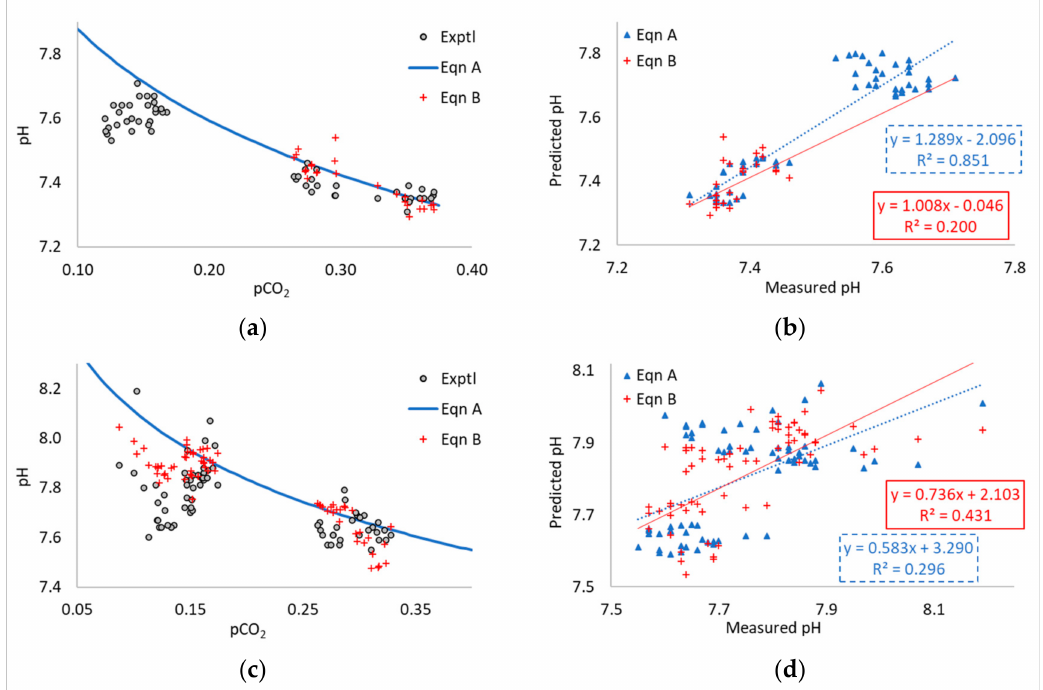
Figure A6. Experimental pCO 2 and pH values and predicted pH from Equation A for mesophilic ( a , b ) and thermophilic ( c , d ) CO 2 biomethanisation of pig manure associated with Zhu et al. [50–52]. See Table S4 for operating conditions and average results for each